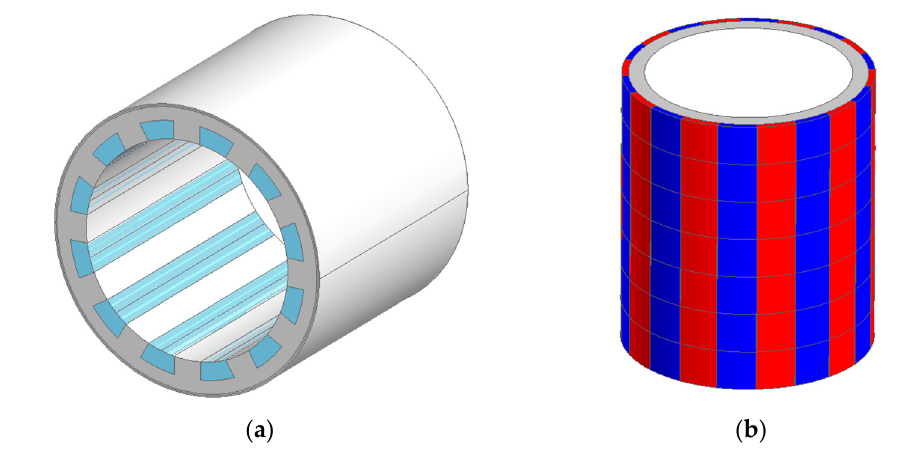
Figure 4. Definition of the main geometric parameters of PMVM structure.